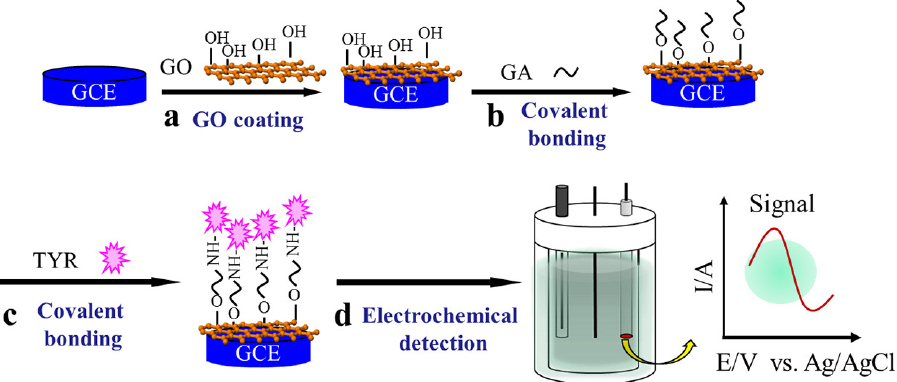
Figure 7. Schematic presentation of the development of TYR/GA/GO/GCE biosensor for the electrochemical determination of phenol derivatives; ( a ) GO casting on GCE, ( b ) covalent bonding of GO and GA, ( c ) covalent bonding of GA and TYR, and ( d ) electrochemical detection of phenol derivatives [44].